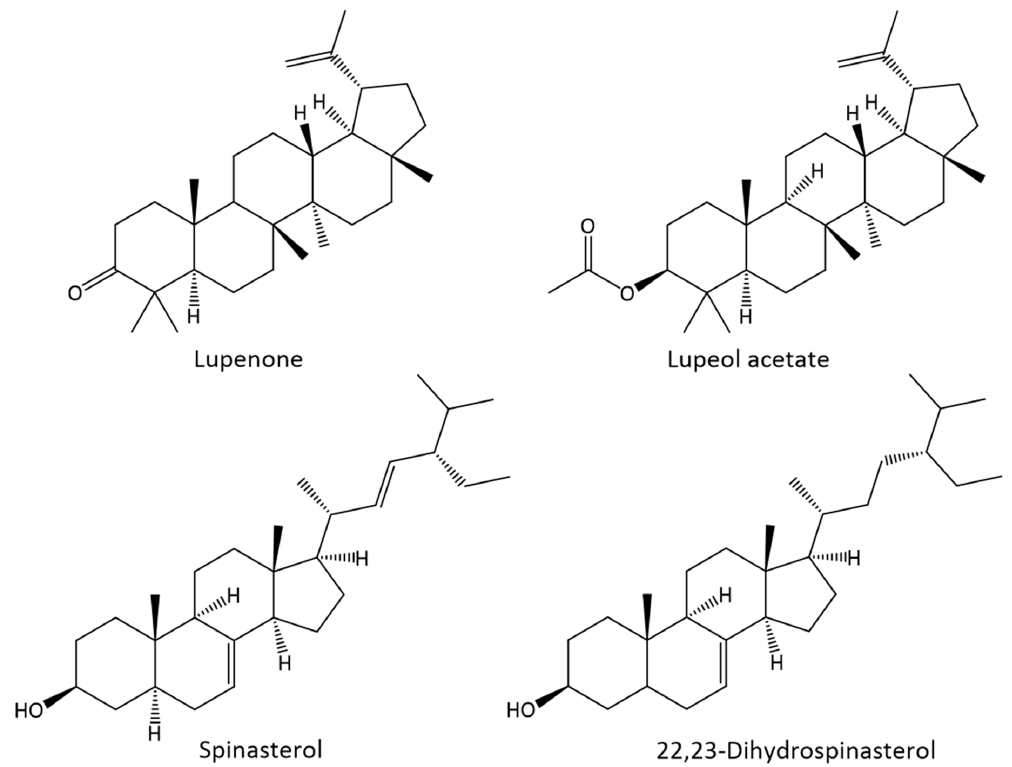
Figure 2. Chemical structures of the major constituents identified in the A. dealbata bark, wood and leaves lipophilic